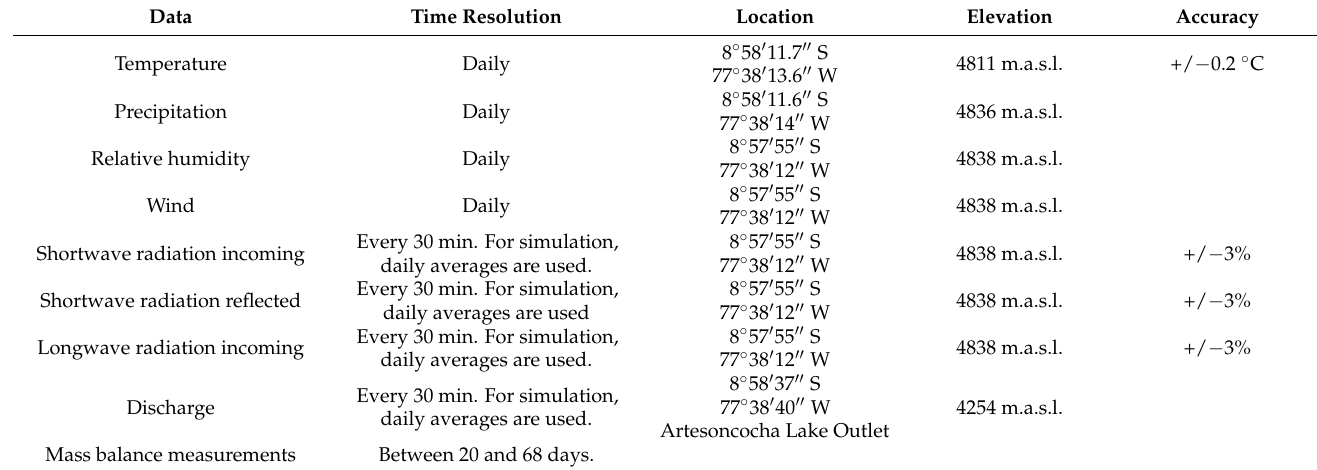
Table 1. Climate, discharge, and mass balance data used in the glacier